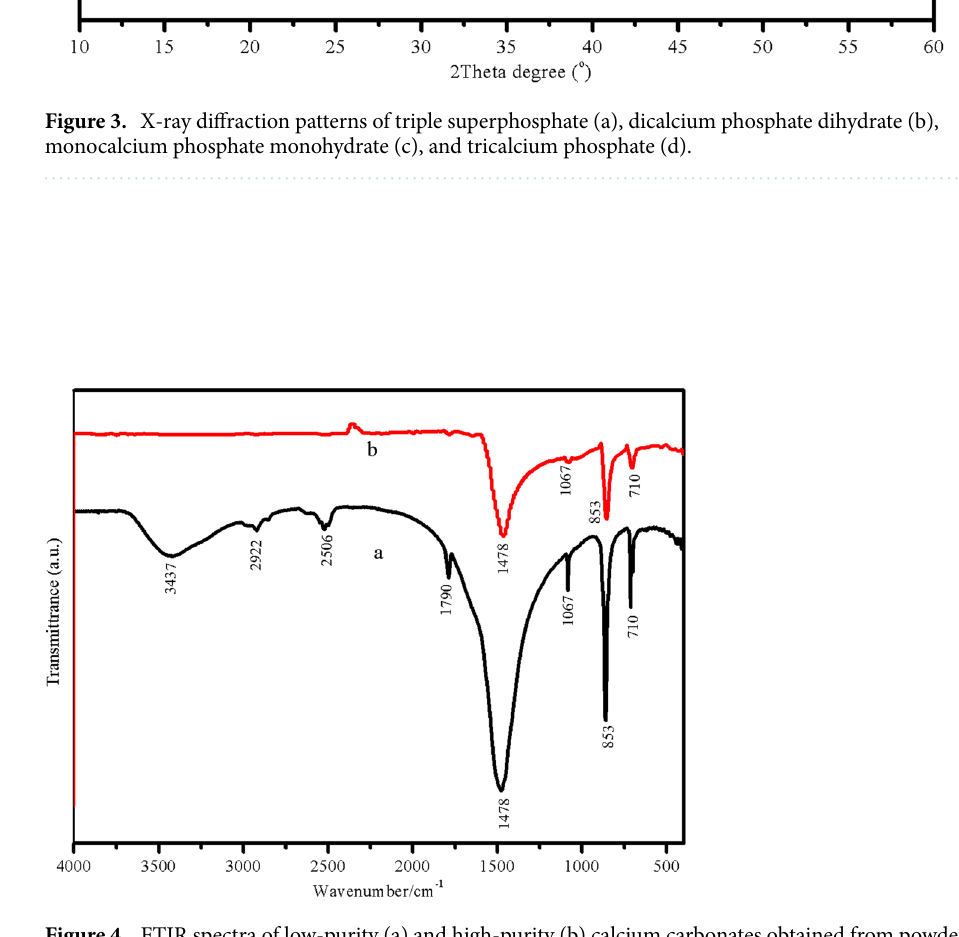
Figure 4. FTIR spectra of low-purity (a) and high-purity (b) calcium carbonates obtained from powdered eggshell